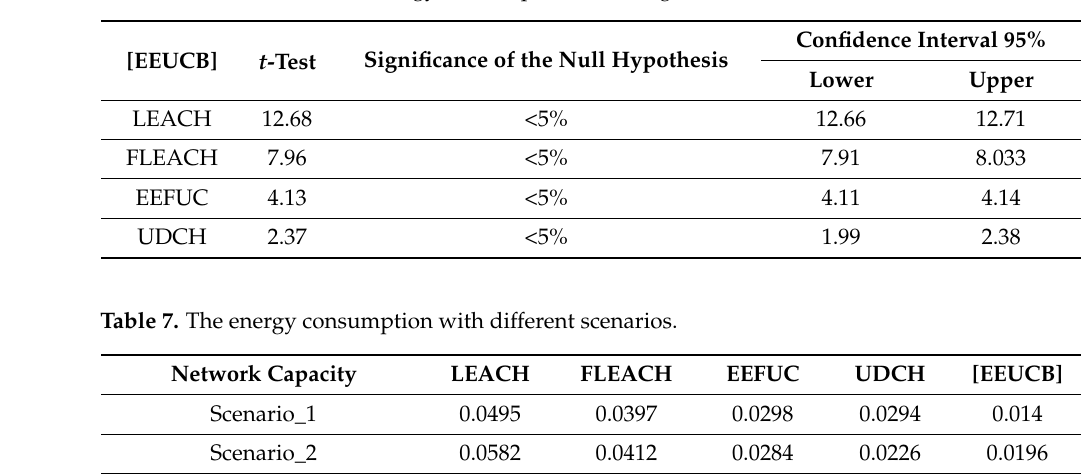
Figure 12. The average energy consumption. Table 6. Results of t -test of energy consumption for a single round.